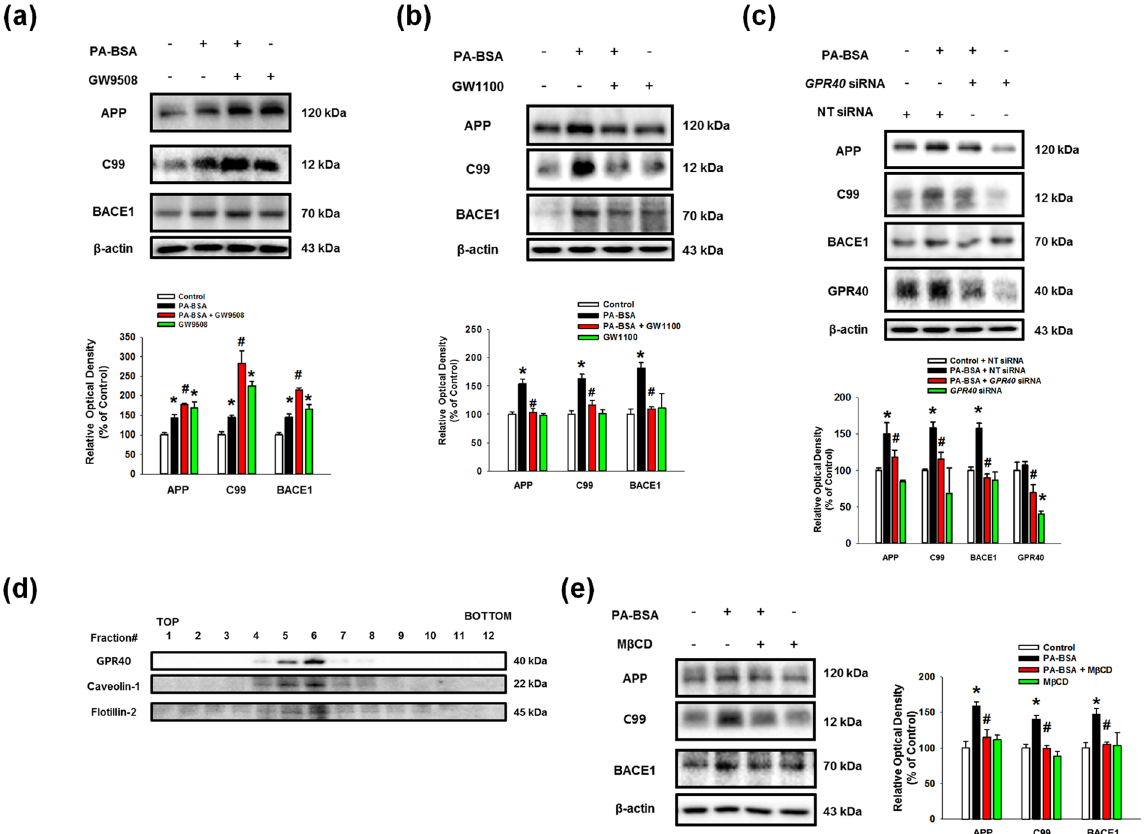
Figure 3. PA-BSA increased APP and BACE1 expressions through lipid raft-dependent GPR40 pathway. ( a , b ) SK-N-MC cells were pre-treated with GW9508 (10 μ M) and GW1100 (10 μ M) for 30 min prior to treatment of PA-BSA (50 μ M) for 24 h. The expressions of APP, BACE1, C99 and β -actin were analyzed by western blot. Data are reported as a mean ± S.E.M. n = 4 . ( c ) GPR40 and NT siRNAs were transfected to SK-N-MC cells for 12 h prior to incubation with PA-BSA (50 μ M) for 24 h. The expressions of APP, C99, BACE1, GPR40 and β -actin were assessed with western blot. Data are reported as a mean ± S.E.M. n = 4 . ( d ) Sucrose gradient-fractionized samples were blotted with GPR40, Caveolin-1 and Flotillin-2 antibodies. ( e ) SK-N-MC cells were pre-treated with M β CD (500 μ M) for 1 h prior to incubation with PA-BSA (50 μ M) for 24 h. The expressions of APP, C99, BACE1 and β -actin were measured by western blot. Data are reported as a mean ± S.E.M. n = 4 . Each blot result shown is representative image. * p < 0.05 versus control, # p < 0.05 versus PA-BSA